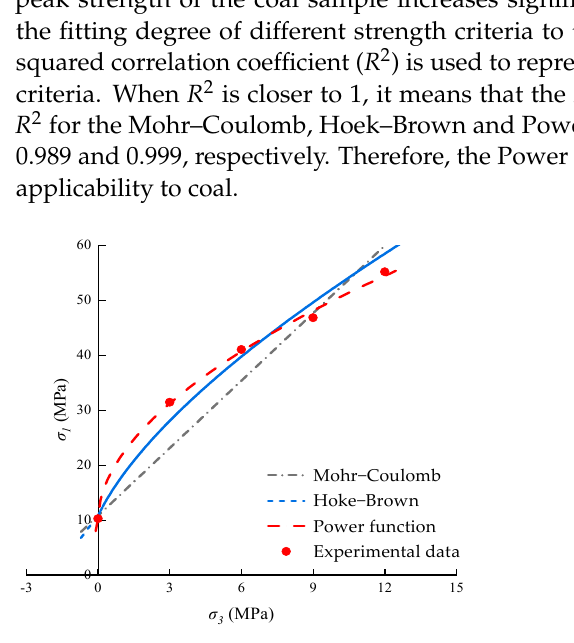
Table 2. Mechanical test results of samples with 0°.